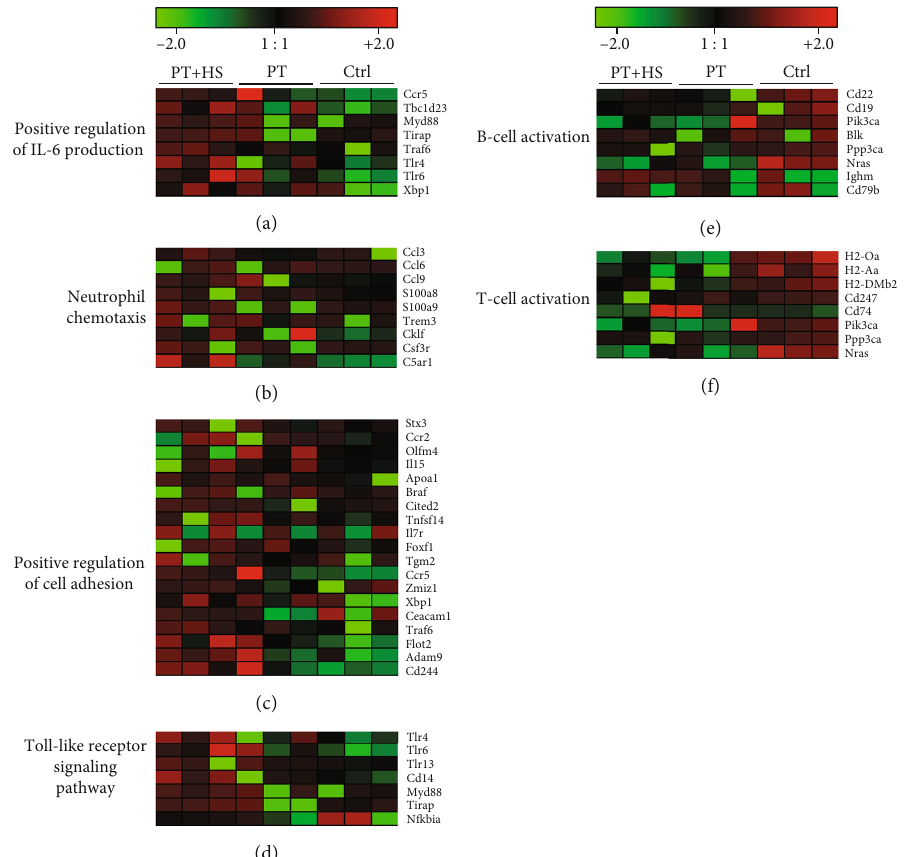
Figure 3: Heat map demonstrating the gene expression in the three experimental groups PT+HS, PT, and Ctrl; each column represents one animal. The high expression value of genes is shown in red and the low expression in green. Signi fi cantly upregulated genes of the pathways positive regulation of IL-6 production (a), neutrophil chemotaxis (b), positive regulation of cell adhesion (c), and toll-like receptor signaling pathway (d), as well as signi fi cantly downregulated genes of the pathways B-cell activation (e) and T-cell activation (f) are